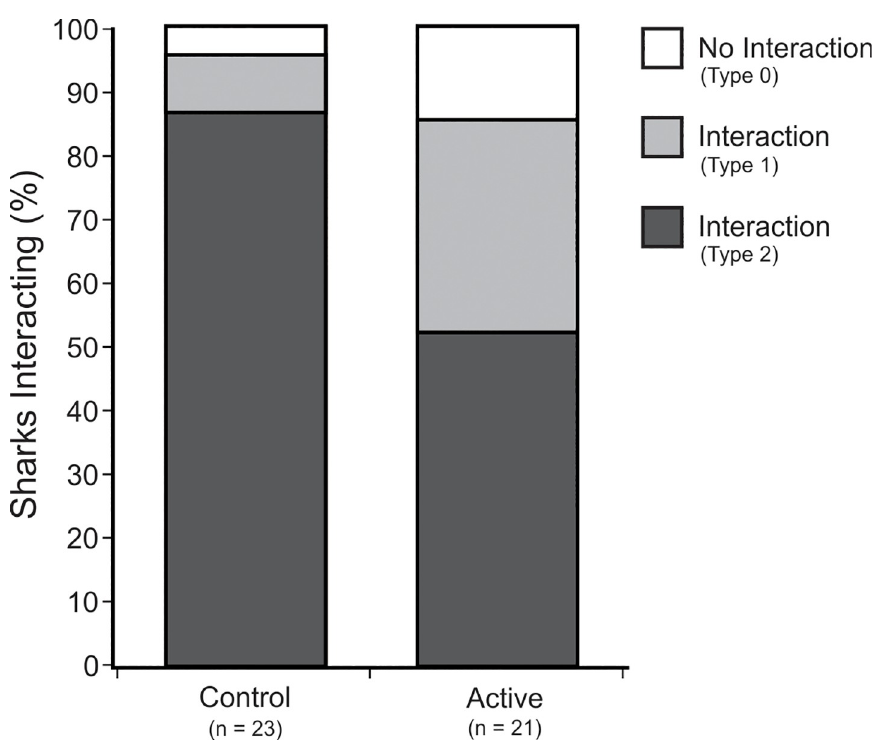
Fig 4. Proportion of interactions (Type 0, 1, and 2) by C . carcharias during control and active trials. n refers to individual